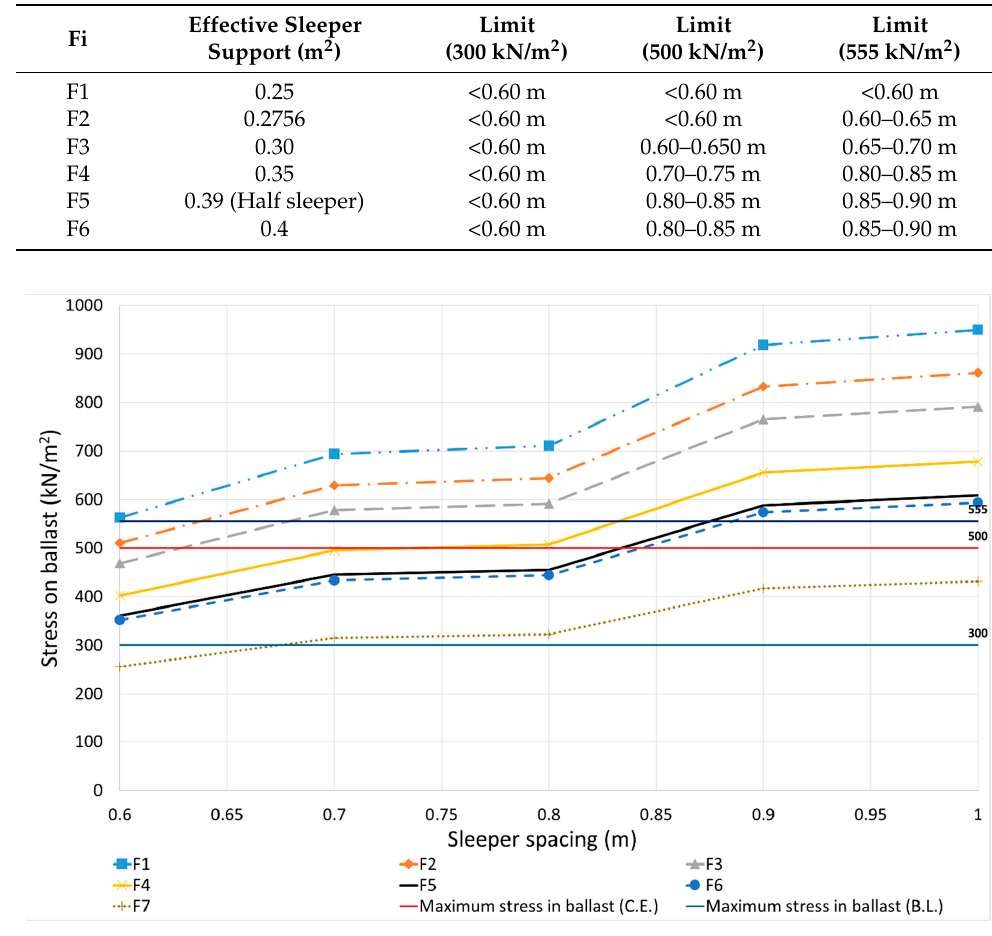
Figure 12. Importance of effective area considered under sleeper. It is important in order to calculate the stress in the ballast surface just under the sleeper.